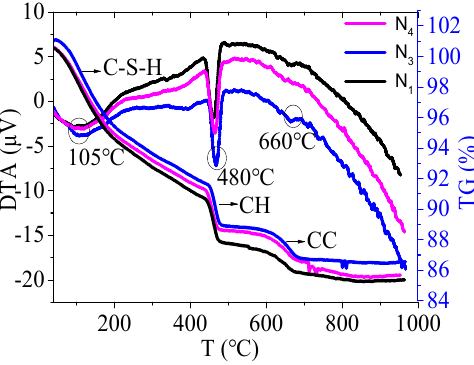
Figure 9. The TG − DTA curves of the cement-based materials with different contents of NSN. Figure 9. The TG-DTA curves of the cement-based materials with different contents of